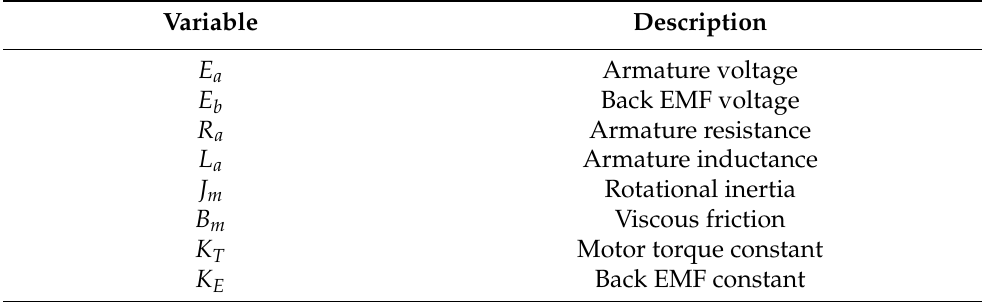
Table 1. Experimental actuator